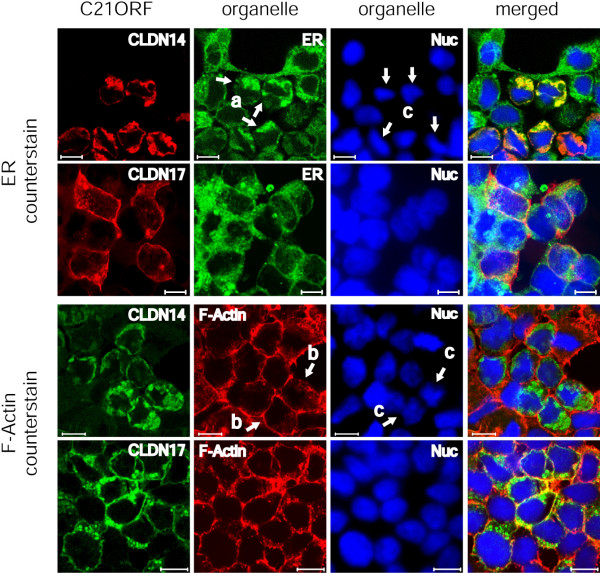
Influence of Chr21 protein over-expression on cellular physiology. Over-expressed claudin-14 was retained in the retracted endoplasmic reticulum (a), which resulted in loss of cell-membrane protrusions (b). Claudin-17 localized in the plasma membrane and its expression did not influence cell morphology. A distinct change in nuclear shape (c) was observed in cells expressing claudin-14 but not in those expressing claudin-17. The scale bar represents 10 μm.